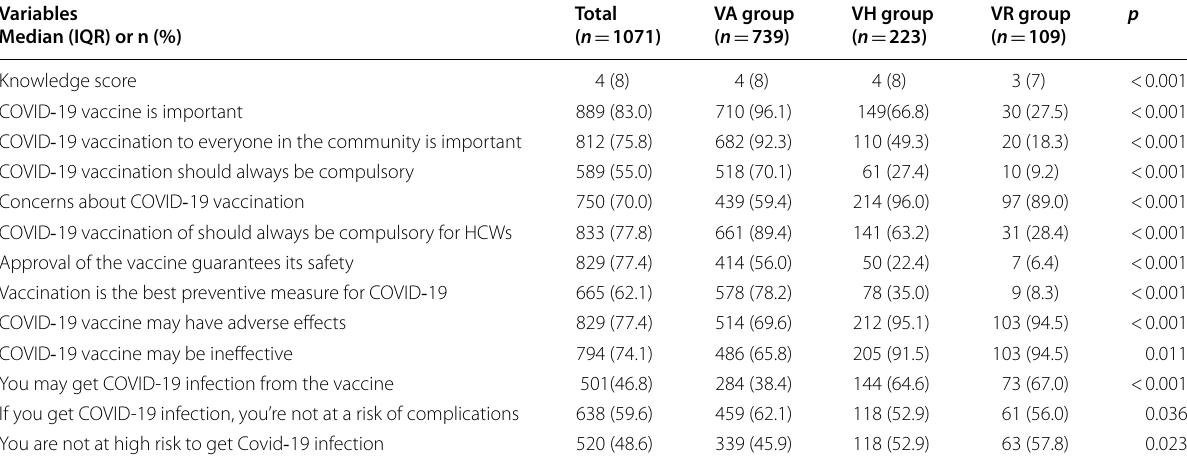
Table 2 Knowledge and beliefs of the university students about COVID-19 vaccination ( n